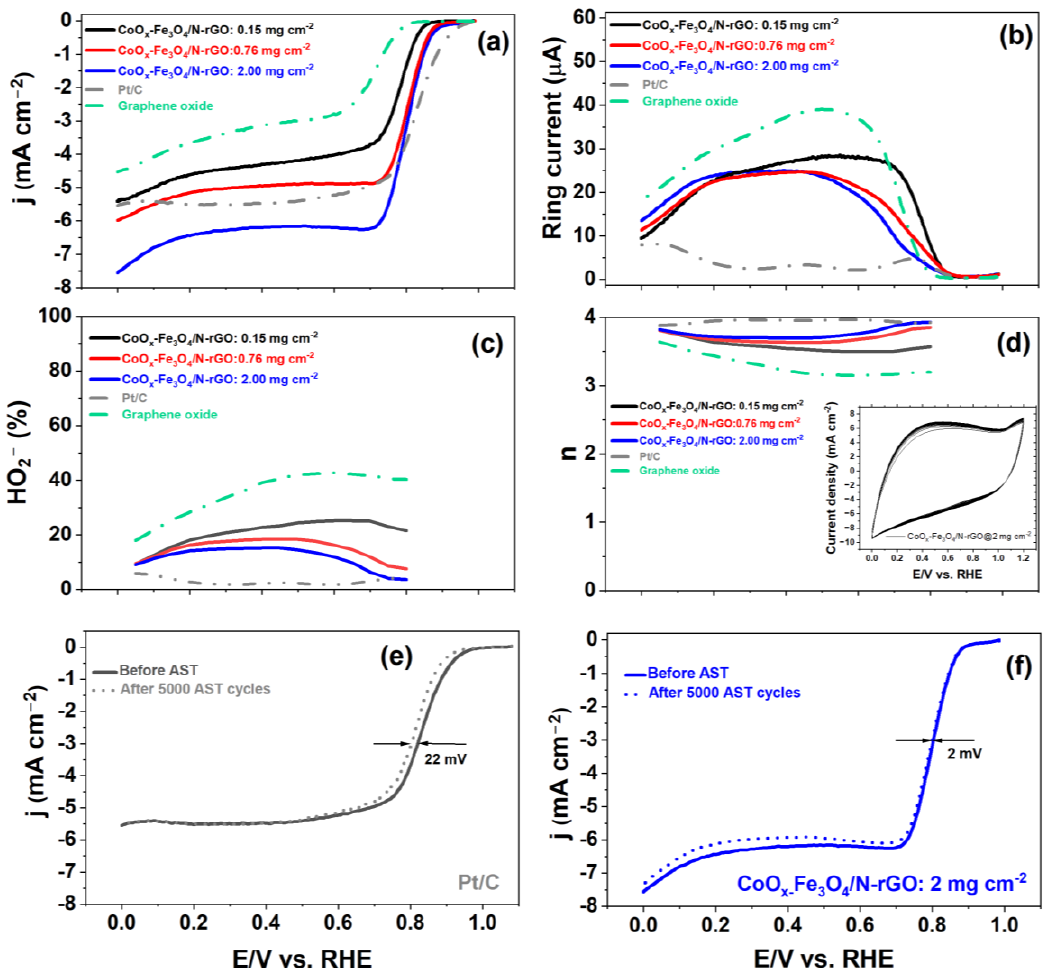
Figure 5. ORR voltammograms of CoO x - Fe 3 O 4 /N - rGO with varied loadings of 0.15, 0.76, and 2.00 mg cm −2 ; GO (0.15 mg cm −2 ); and Pt/C (0.013 mg Pt cm −2 ) ( a ); the corresponding H 2 O 2 generation ( b ); the corresponding % H 2 O 2 ( c ); the number of electrons transferred for ORR ( d ); 50 representative CVs of CoO x - Fe 3 O 4 /N - rGO loaded to 2.00 mg cm −2 at a scan rate of 100 mV s −1 in argon - saturated 0.1 M KOH electrolyte (inset of ( d )); ORR voltammograms before and after 5000 AST load cycles with CoO x - Fe 3 O 4 /N - rGO (2.00 mg cm −2 ) ( e ); and Pt/C ( f ). The data were recorded with an O 2 - saturated 0.1 M KOH electrolyte solution at a scan rate of 2 mV s −1 with 1600 RPM from 1.0 to 0.0 V.